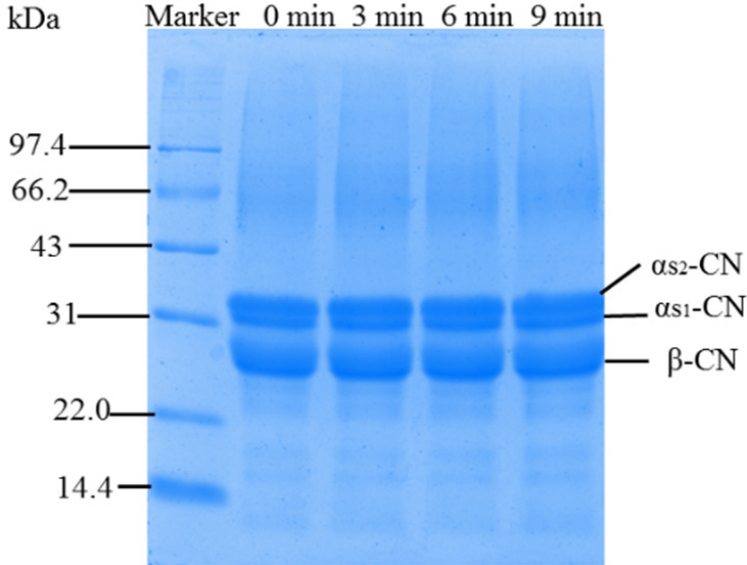
Figure 1. SDS-PAGE pattern of high-intensity ultrasound treated SC.